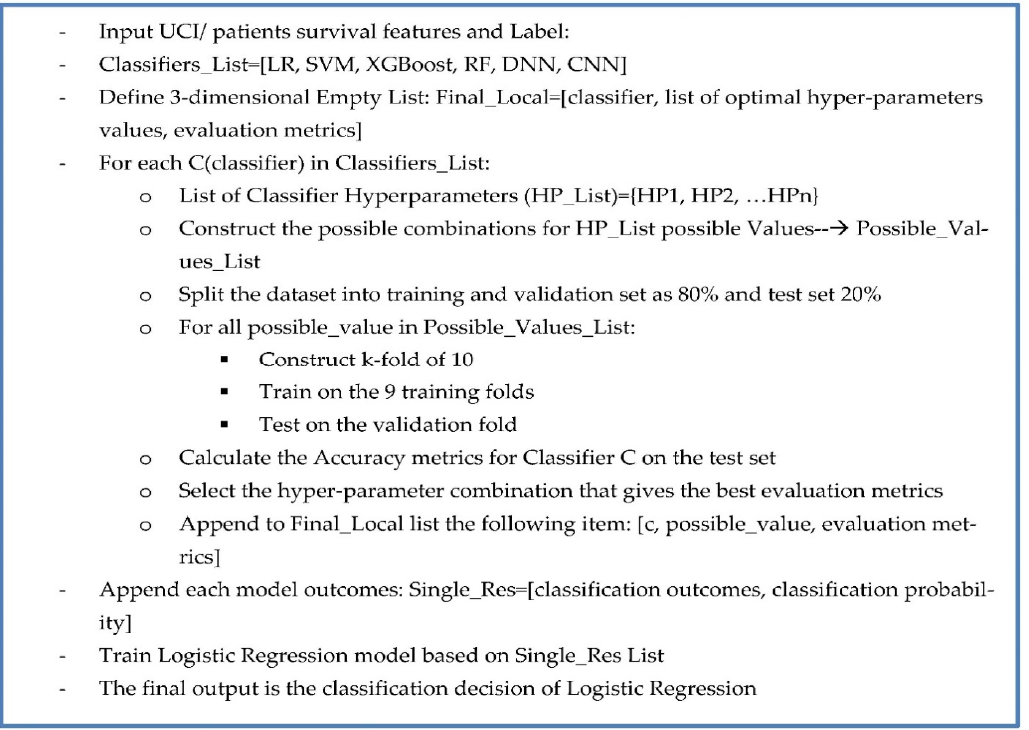
Figure 4. Framework steps.